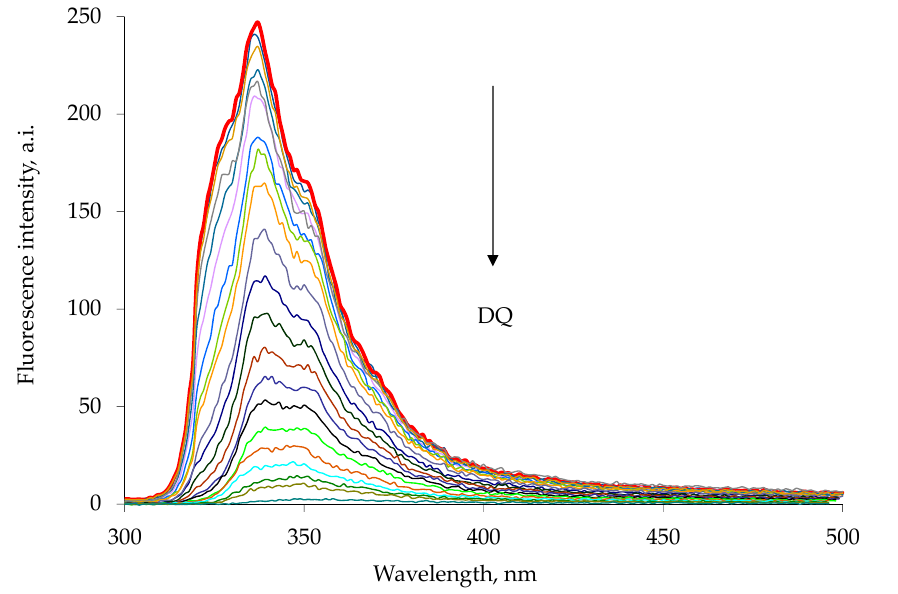
Figure 5. Fluorescence quenching of 1a host with increasing diquat concentration, DQ, in chloroform–methanol 1:1 solution at 25 °C. The emission spectra were measured with excitation at 285 nm. Each spectrum is reported with different color line (Entry 1–18 Table 3). Table 4. Experimental data for the determination of spectra reported in Figure 6. The V 1b and V DQ